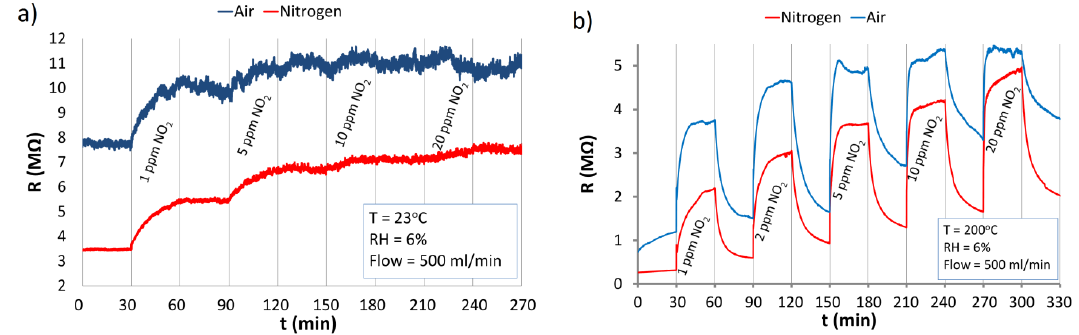
Figure 8. The reaction of ZnO nanostructures to NO 2 in the atmospheres of synthetic air and nitrogen at: ( a ) RT; ( b ) elevated temperature of 200 °C.